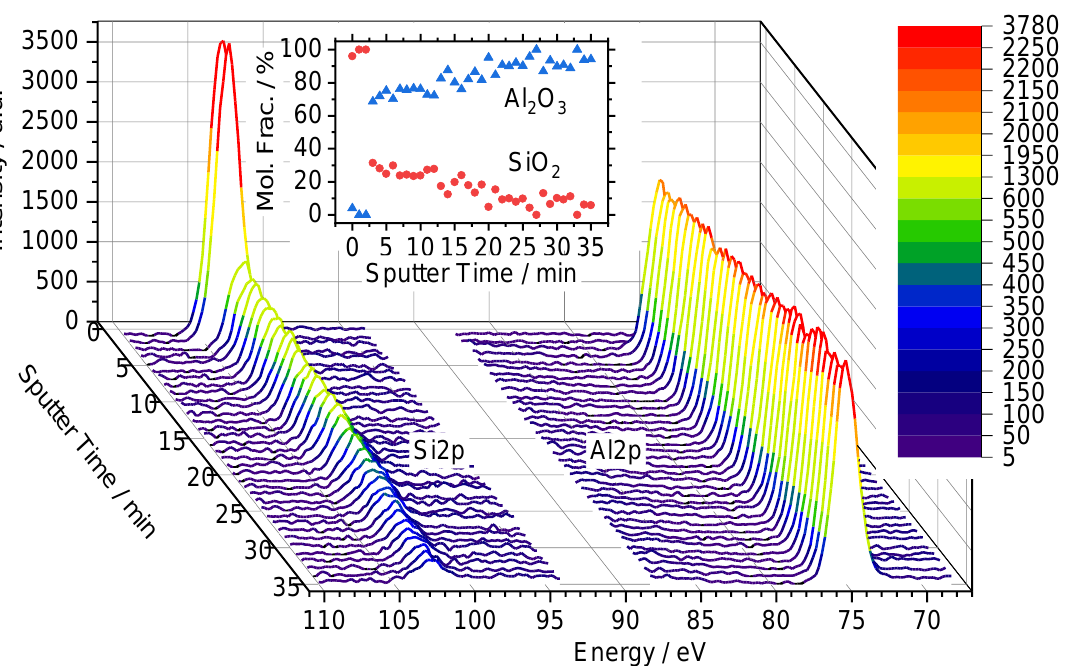
Figure 3. Si2p and Al2p XPS peaks of membrane Si-650 throughout the Ar surface sputter. Inset shows Al 2 O 3 and SiO 2 mole fractions vs. sputter time.